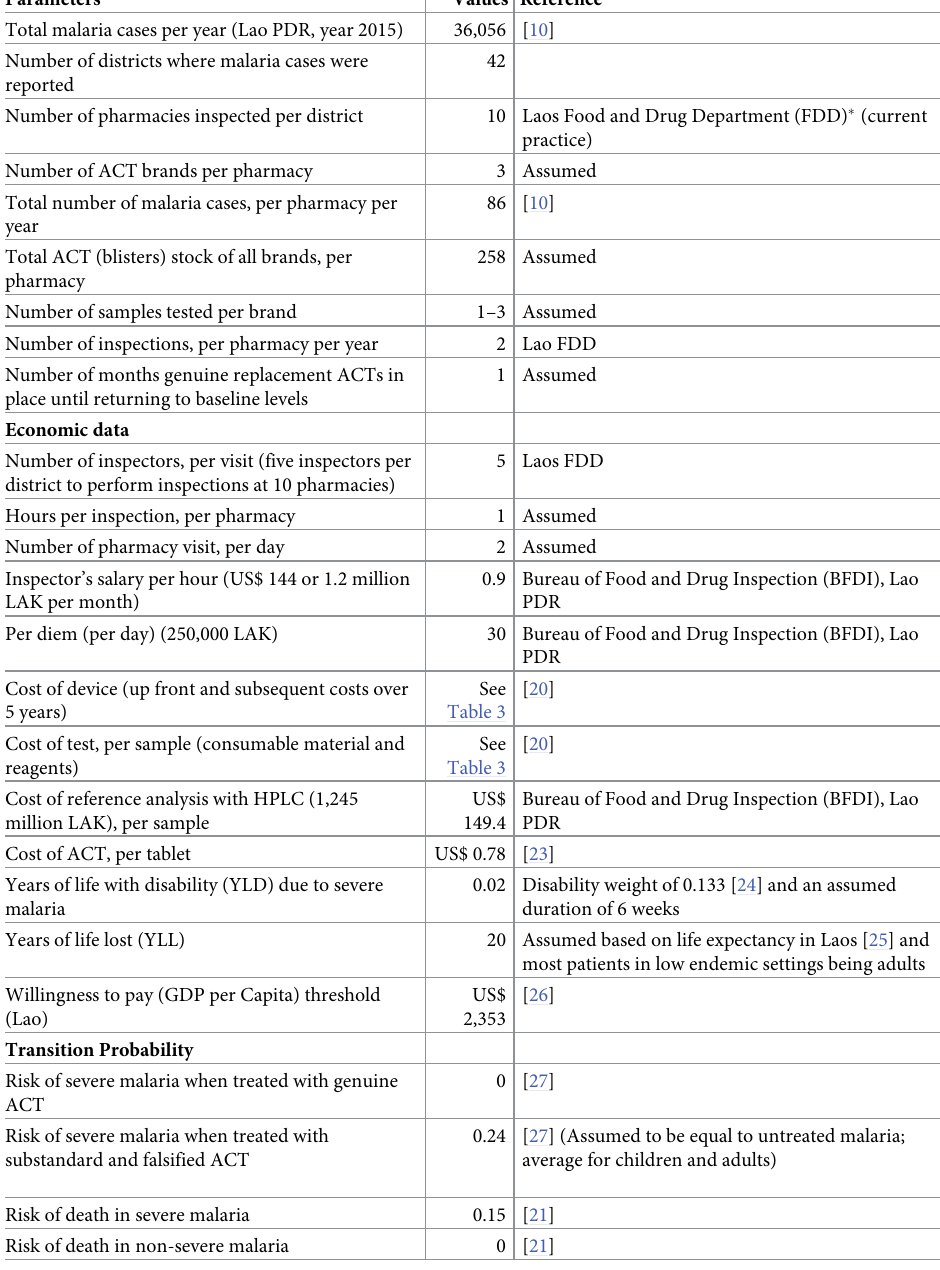
Table 2. List of parameters used in the cost-effectiveness analysis